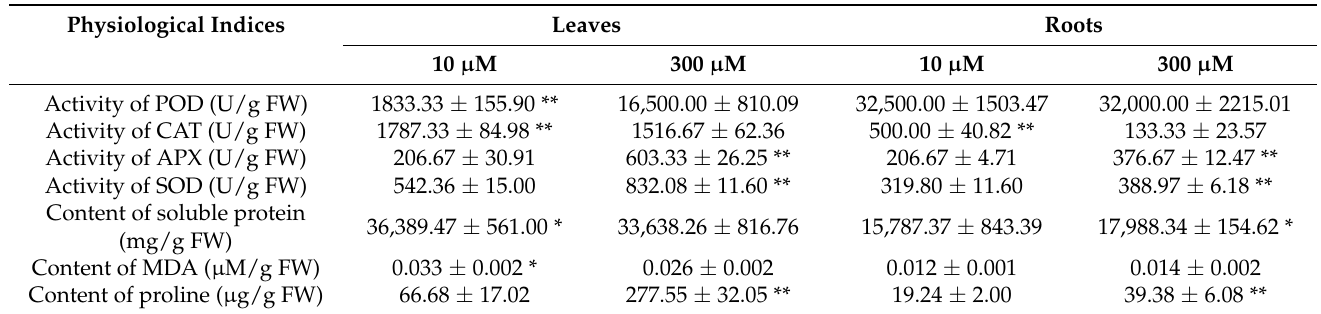
Table 3. Effects of different manganese treatment concentrations on physiological indices in peanut leaves and roots.